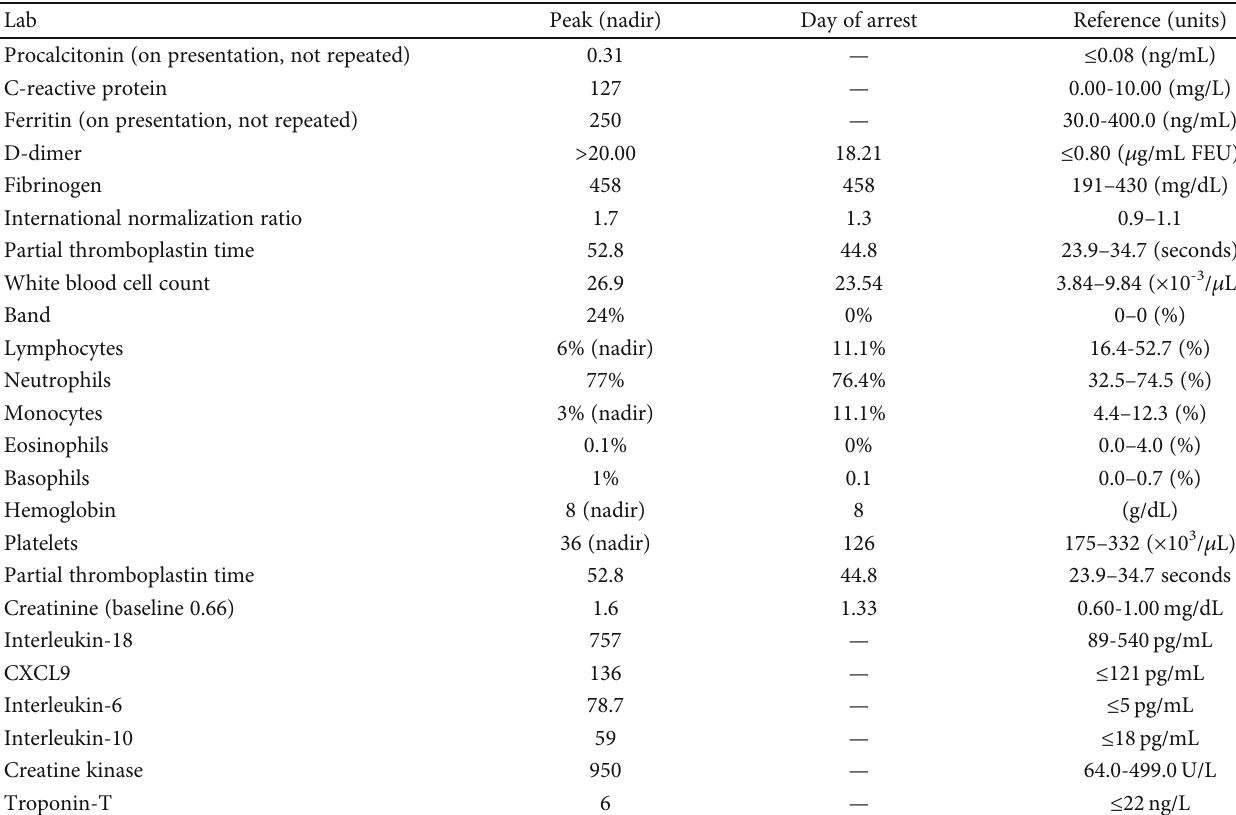
Table 1: Notable lab values. Peak (or nadir) noted as clinically relevant and values on day of arrest.